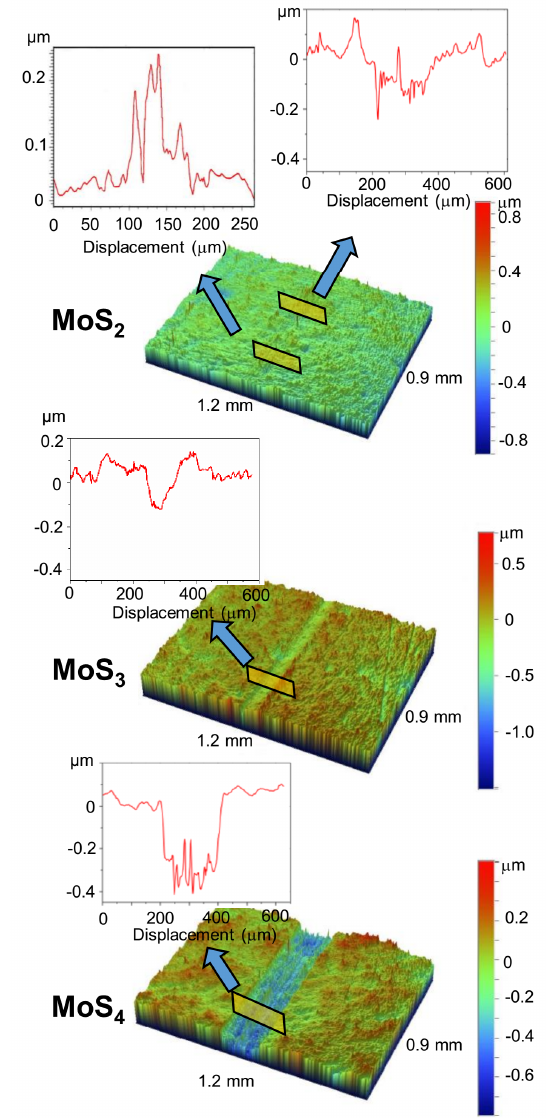
Figure 6. 3D images of the central part of wear tracks formed on the surface of MoS x coatings (with di ff erent S contents) after tribo-testing at − 100 ◦ C in an argon–air mixture (RH ~ 9%). The inserts different S contents) after tribo-testing at −100 °C in an argon–air mixture (RH ~ 9%). The inserts illustrate the depth profiles of the wear scars on the illustrate the depth profiles of the wear scars on the coatings.